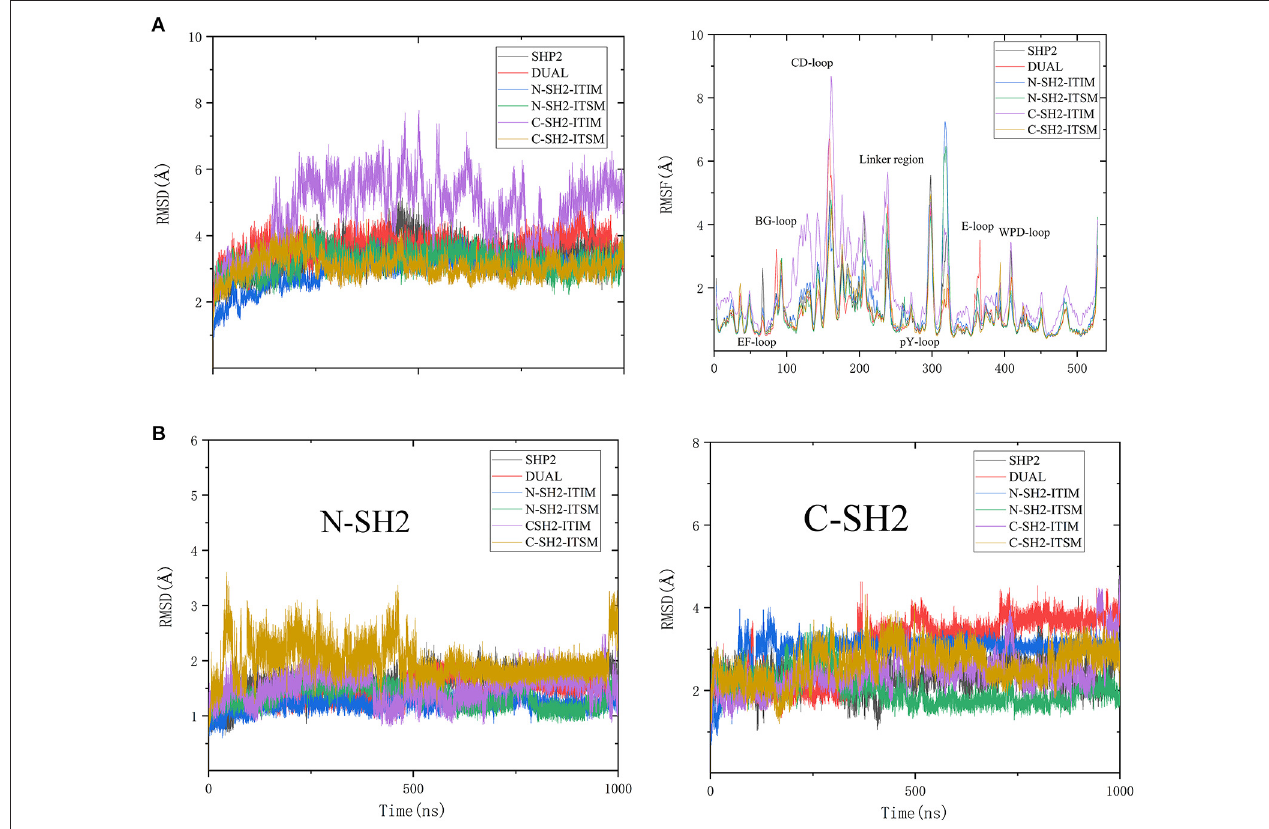
FIGURE 2 | RMSD values and RMSF value of SHP2 in all systems (A) , and the RMSD values of N-SH2 and C-SH2 domains in all systems (B)